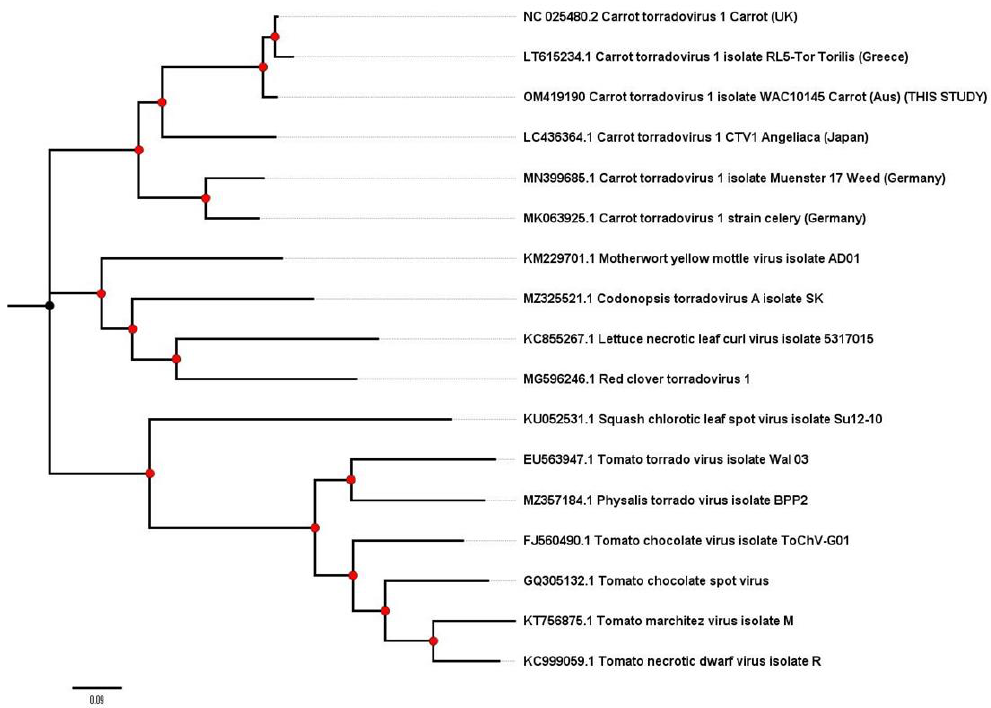
Figure 4. Phylogenetic tree of complete RNA2 nucleotide sequences of CaTV1 and a range of related torradoviruses. For the CaTV1 isolates, host and country of isolation are included.